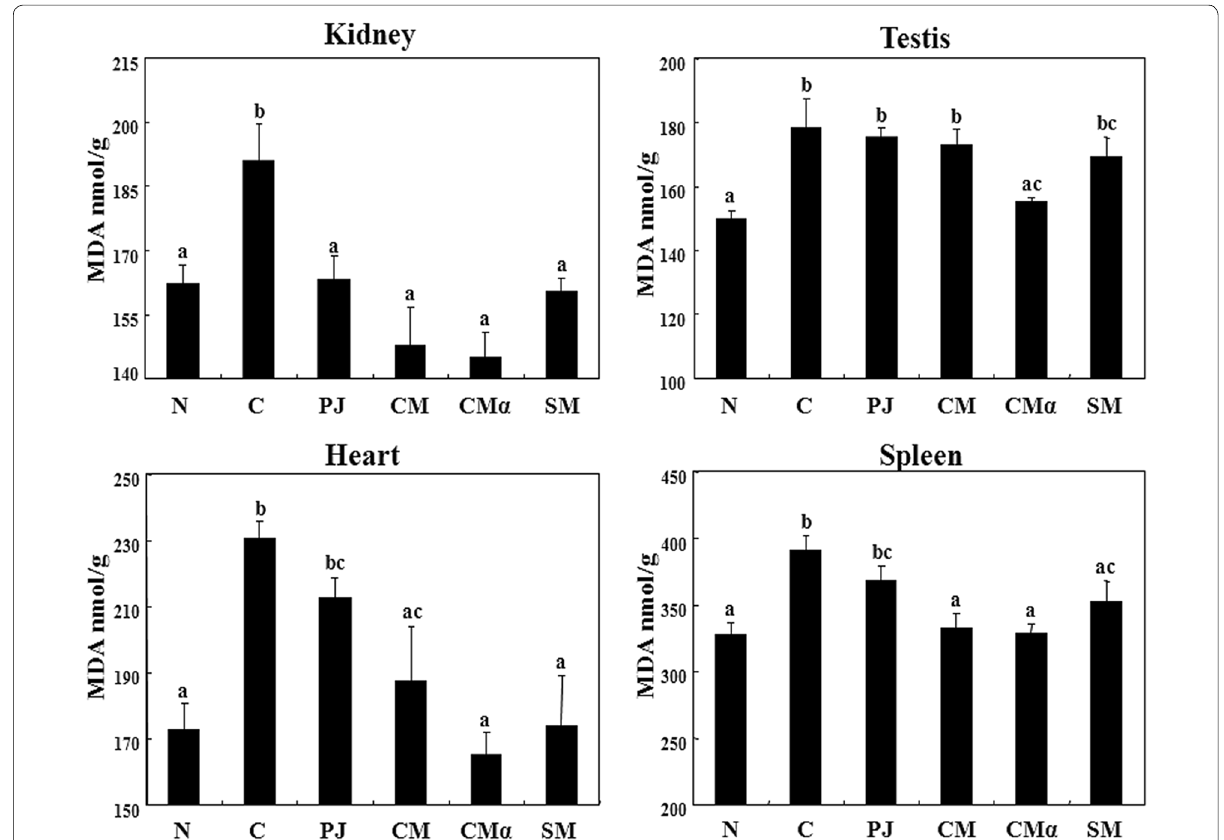
Fig. 3 Concentrations of thiobarbituric acid‑reactive substances (TBARS) in kidney, heart, spleen and